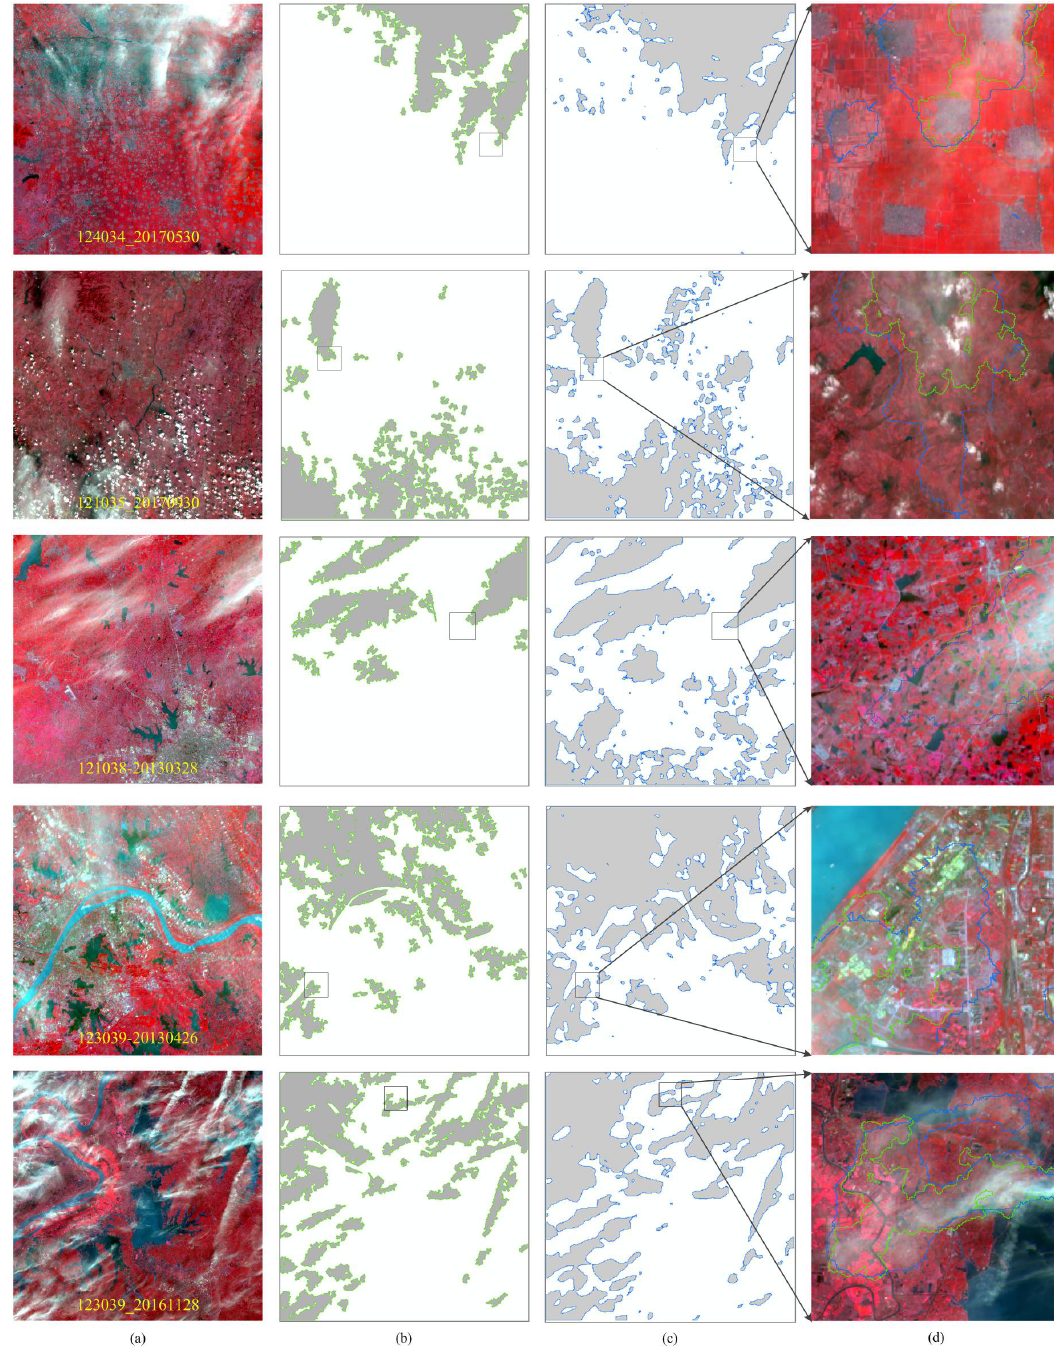
Figure 6. Thin-cloud mask results of the OLI. Column ( a ) is the original image; column ( b ) shows the cloud mask results by our method; column ( c ) shows the results by contrasting methods; and column ( d ) shows the magnified cloud mask results of the local area, where the blue line represents the contrasting results and the green line represents our method results.